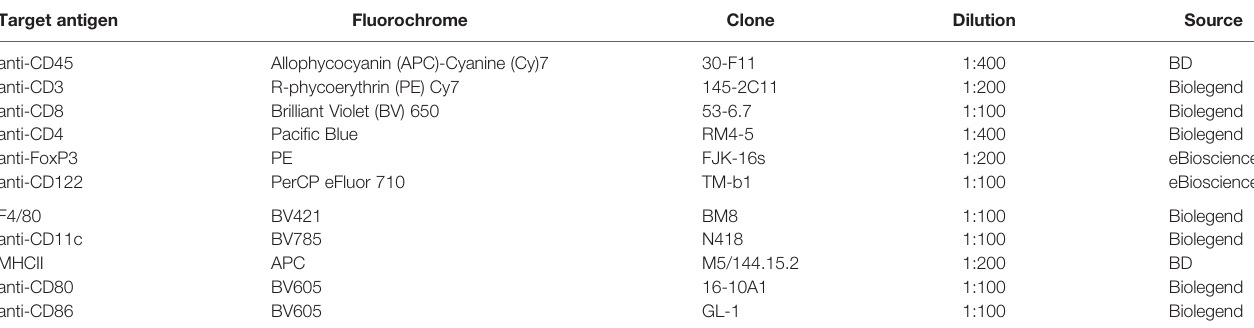
TABLE 1 | Summary of antibodies used in the present